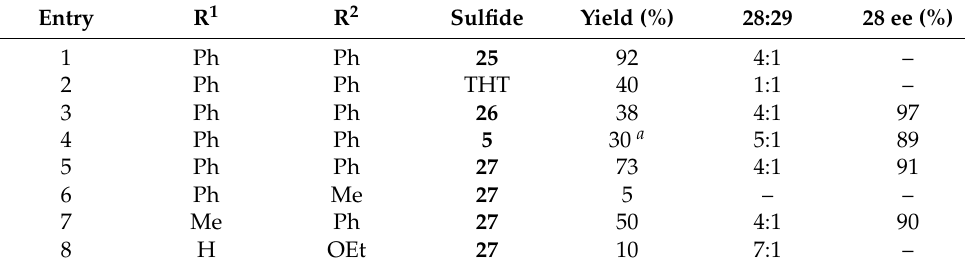
Table 15. Scope of Aggarwal’s catalytic cyclopropanation (Scheme 44).